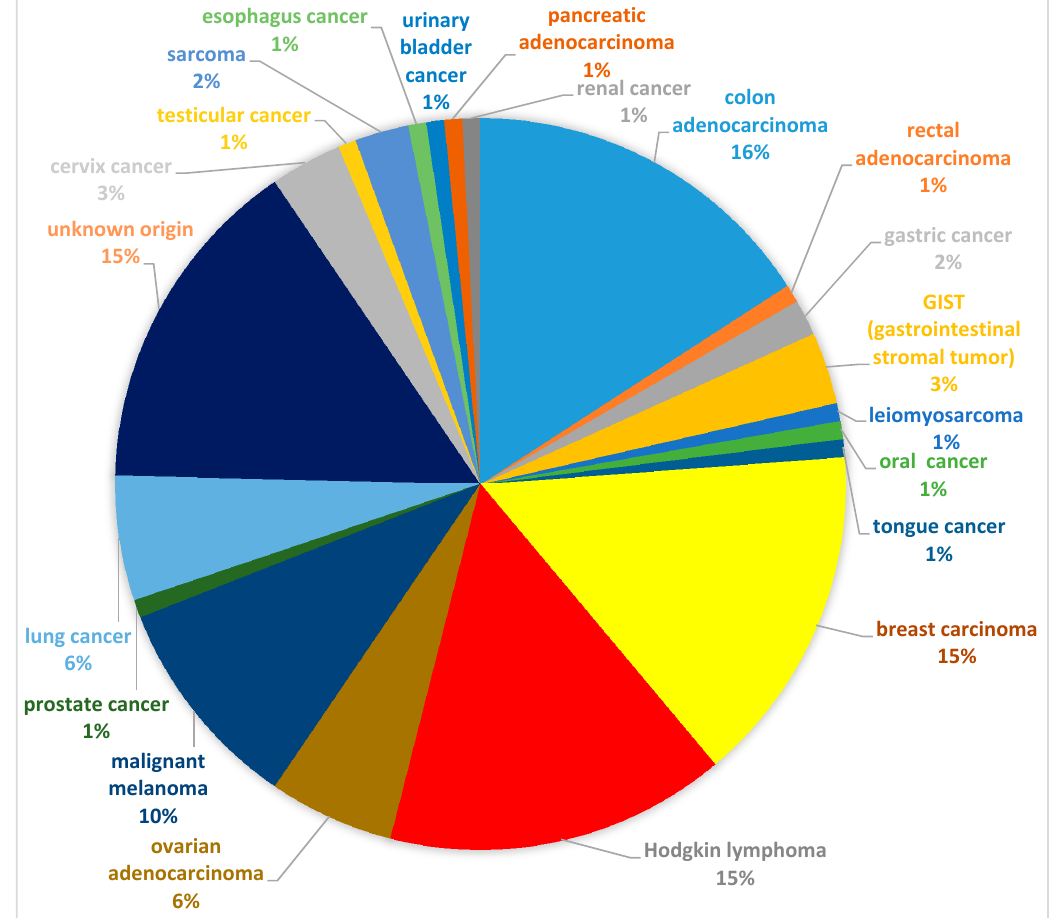
Figure 1. Types and distribution of primary malignant diseases.